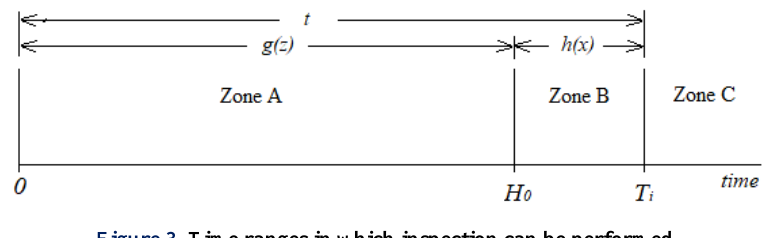
Figure 3. Time ranges in which inspection can be